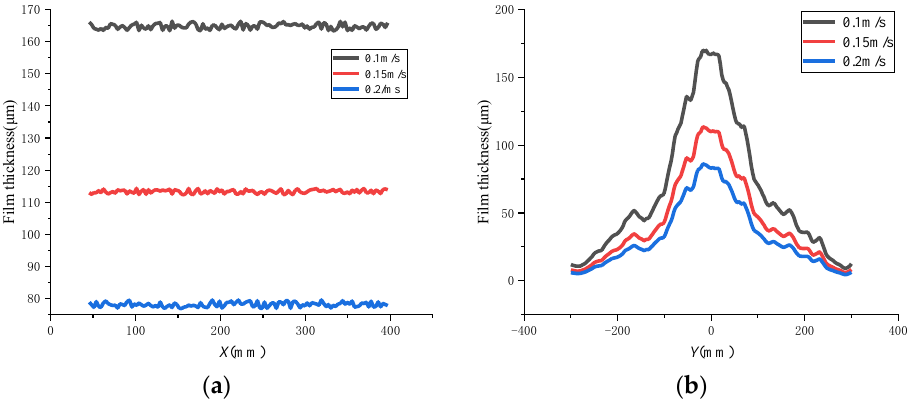
Figure 18. Film thickness distributions at different spraying speeds. ( a ) The film thickness of movement of the spray gun axis. ( b ) Axle wire film thickness distribution of the Y-axis.